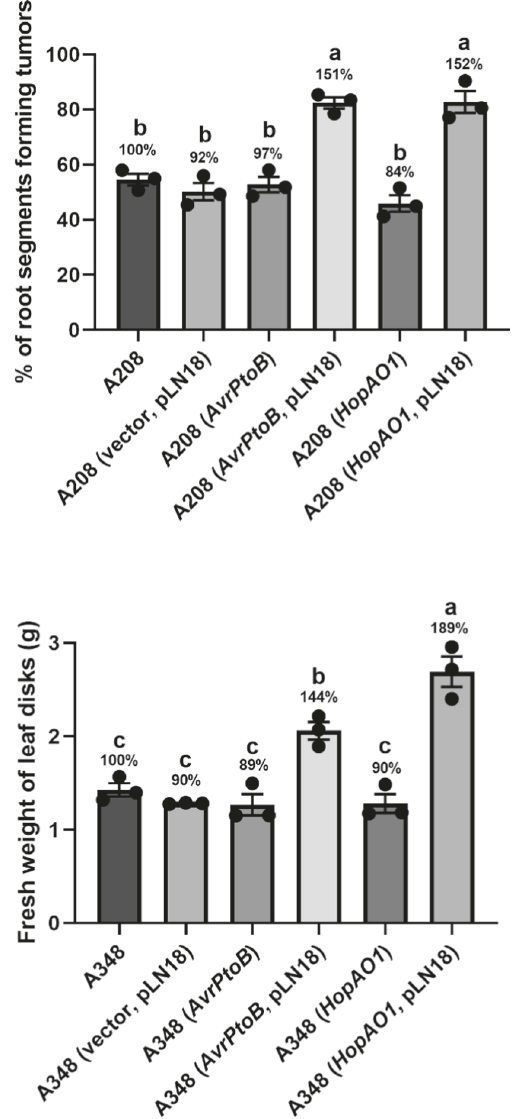
Fig. 4 Engineered A. tumefaciens strains expressing a T3SS and AvrPtoB or HopAO1 greatly increase the stable transformation ef fi ciency of Arabidopsis and N. benthamiana . a Root tumor assay. Arabidopsis root segments were infected with A. tumefaciens strain A208 (A 600 = 0.1) expressing the T3Es AvrPtoB or HopAO1 in combination with or without pLN18. A. tumefaciens strains A208 and A208 (vector, pLN18) were included as negative controls. Root segments forming tumors were counted 4 weeks after A. tumefaciens infection and the percentage of root segments forming tumors was calculated. b Leaf disk transformation assay.